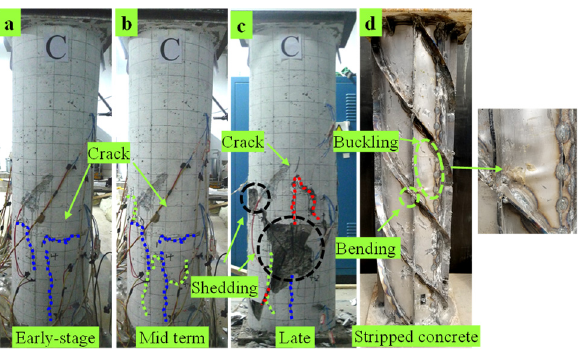
Figure 5. Damage phenomenon of C2. ( a ) Early-stage ( b ) Mid term ( c ) Late. ( d ) Stripped concrete. C3 specimen: At the initial loading stage, when the load increases to 971.9 kN, the vertical micro-cracks extending downward appear in the middle of the specimen. With continuous loading, vertical cracks appeared in the middle and lower parts of each specimen surface, as shown in Figure 6a. When the load reached 1925.2 kN, transverse and longitudinal intersecting cracks appeared at 200 mm from the bottom of the specimen, accompanied by the sound of concrete crushing, as shown in Figure 6b. In the later stage of loading, a large area of concrete fell off along the direction of spiral ribs and the oblique cracks of adjacent surfaces and the failure mode is shown in Figure 6c. The concrete outside the specimen is peeled off, the middle of the steel tube bulges, and the vertical plate has severe bending, as shown in Figure 6d.